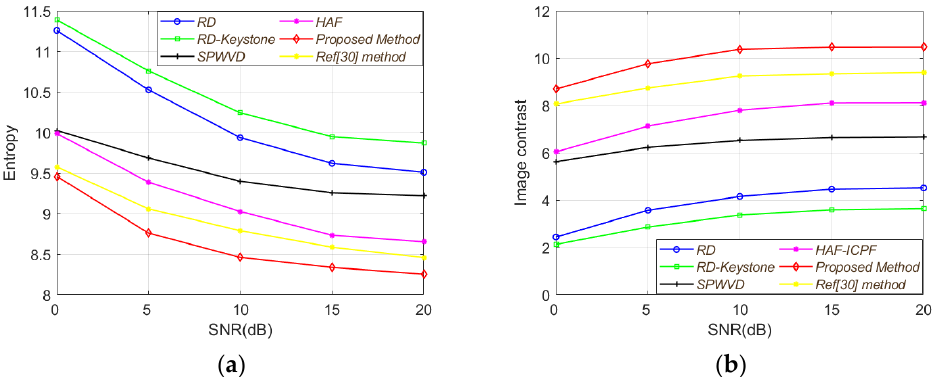
Figure 11. SNR versus entropy curve and SNR versus contrast curve of the six methods: ( a ) SNR versus entropy curves; ( b ) SNR versus contrast curves [30].